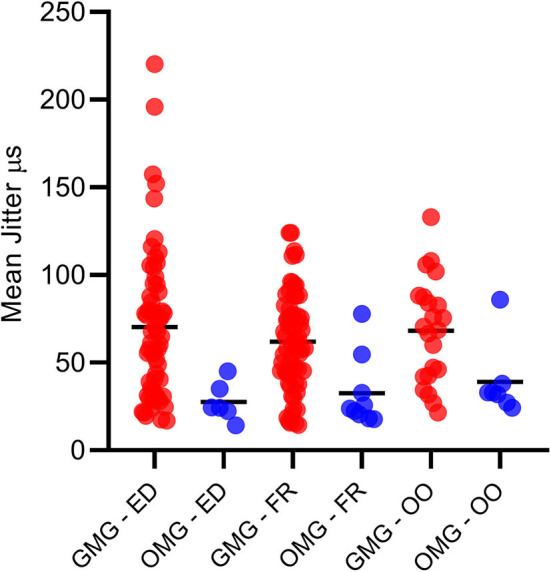
All mean jitter values for the generalized (GMG) and ocular myasthenia gravis (OMG) in Extensor Digitorum, Frontalis, and Orbicularis Oculi muscles. Mean = continuous dash.